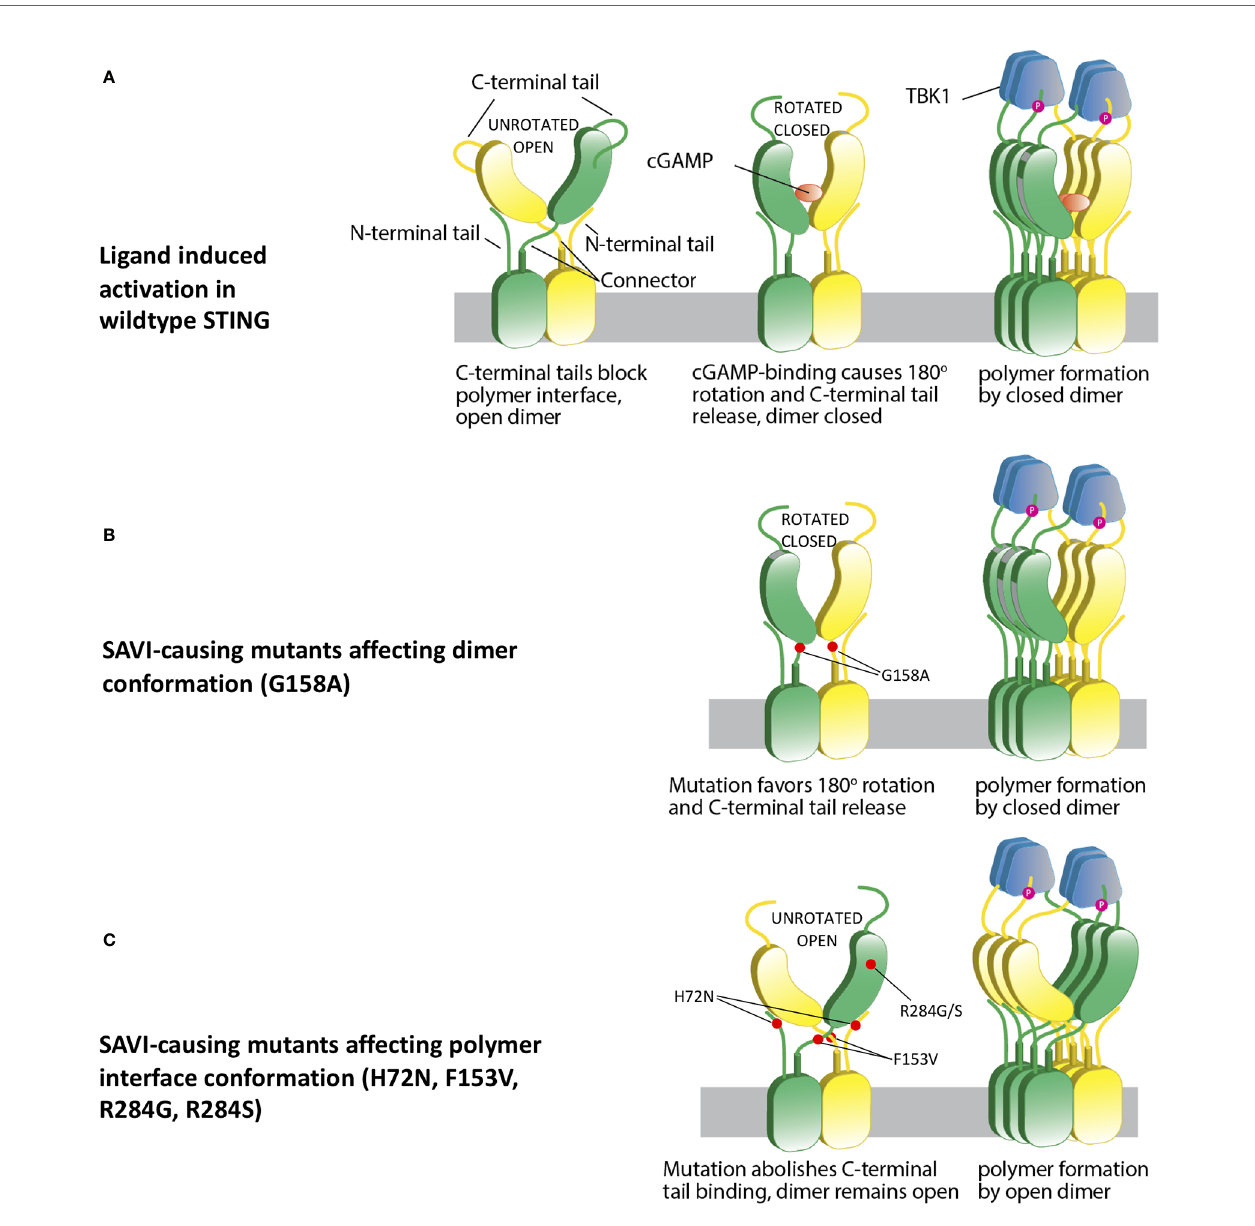
FIGURE 3 | A hypothetical STING activation model reconciles current structural models. (A) Wild type apo STING forms a dimer in open conformation, with C- terminal tail blocking the polymer interface and preventing polymerization. cGAMP binding leads to a 180° rotation and a closed dimer, which also changes the polymer interface conformation and subsequently loses C-terminal tail blocking. This leads to STING polymerization via side-by-side packing and TBK1 recruitment. (B) SAVI mutant G158A “ pushes ” the formation of a closed dimer, which mimics ligand-bound STING and confers autoactivation in the absence of ligand binding. (C) Some other SAVI mutants like R284G, R284S, H72N, F153V directly affect the polymer interface conformation, which leads to release of C-terminal tail binding. The STING dimer remains in the open state, but the polymer interfaces are free of C-terminal tail blocking, which allows polymerization and